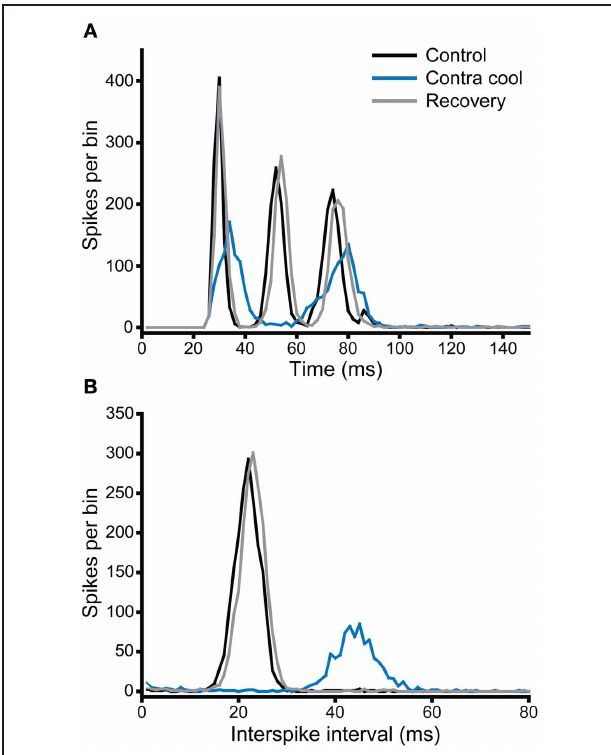
FIGURE 9 | (A) PSTH and (B) ISIH for a unit with a chopper response (CF = 1.1kHz) that showed a change in firing rate and temporal pattern (mediated by an increase in ISI) during cooling of the contralateral IC. Both rate and ISI values recovered on re-warming to control temperature.